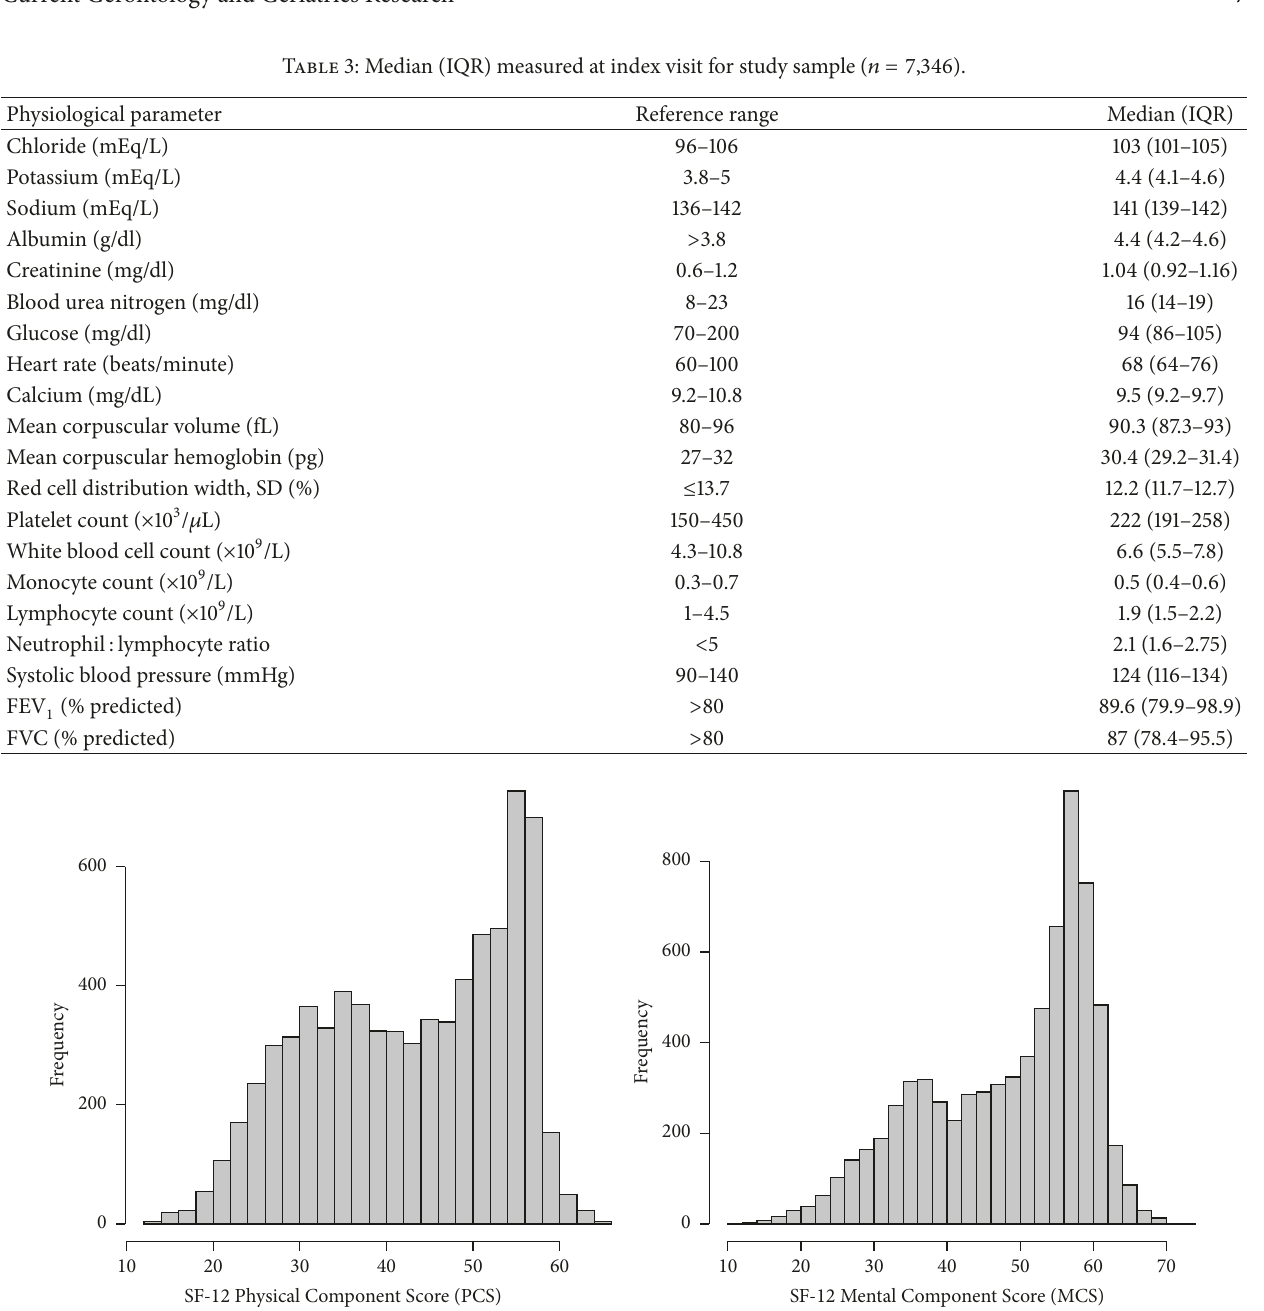
Figure 3: Distribution of SF-12 PCS and MCS in study